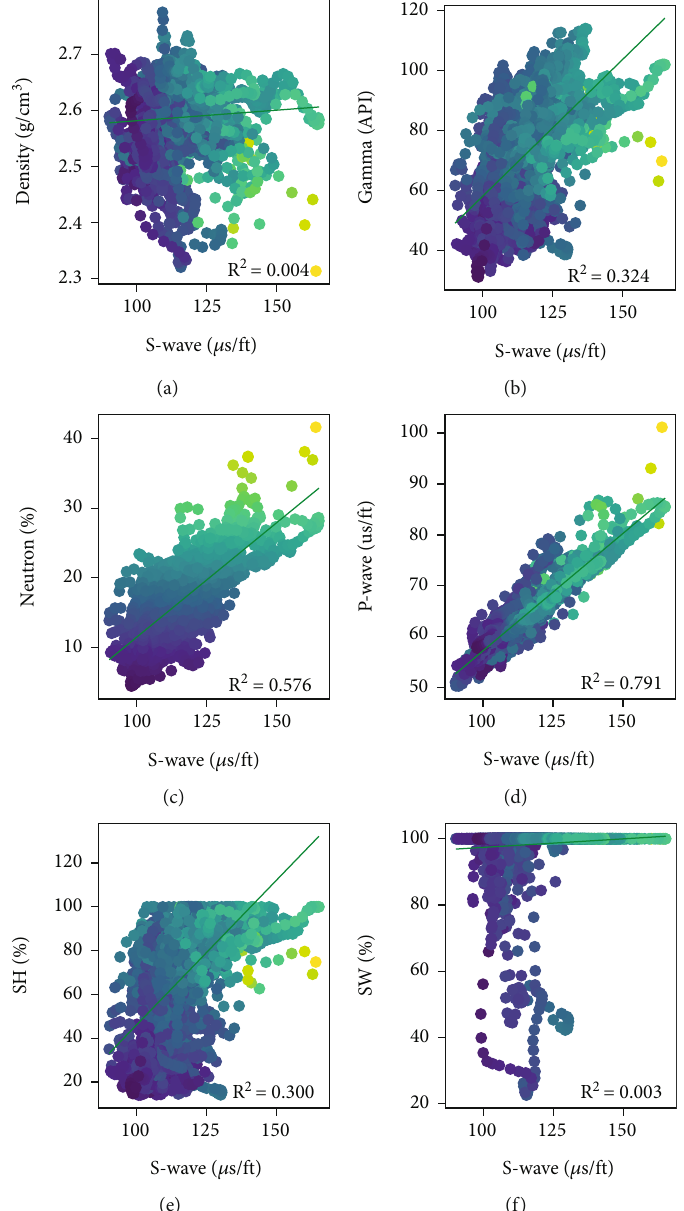
Figure 5: The cross-plot of conventional logging data and shear wave velocity. (a) RHOB – Vs; (b) Gr – Vs; (c) CNL – Vs; (d) Vp – Vs; (e) Sh – Vs; (f) Sw – Vs. R is the correlation coe ffi cient between the two